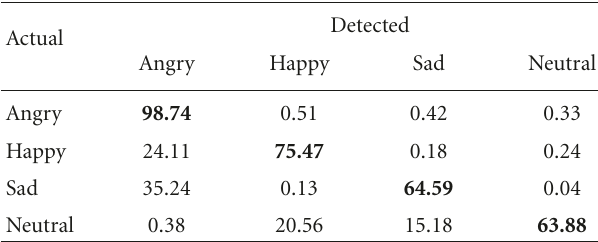
Table 2: Four emotions recognition rate (%) for balanced speaker and text independent test-utterance based: 100 utterances per emotion, random sequence of